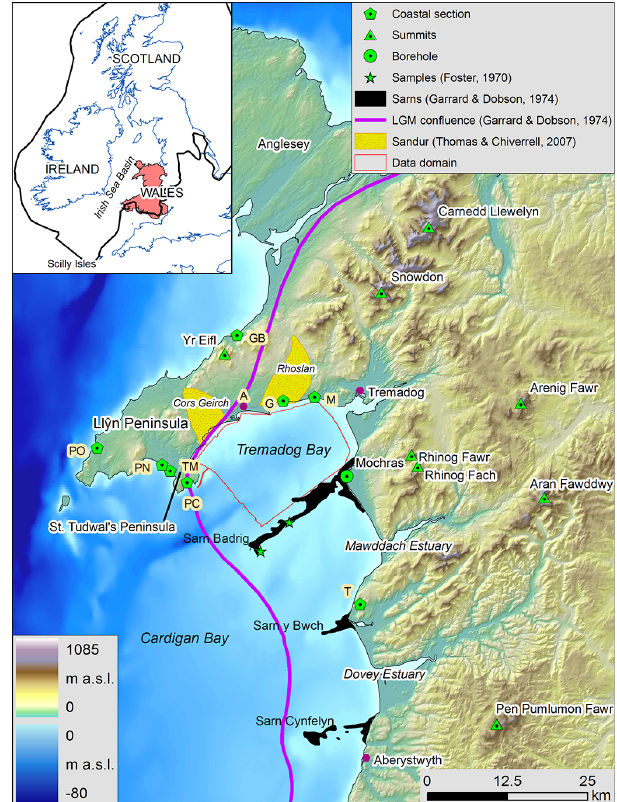
Figure 1. The terrestrially based Welsh Ice Cap, a semi- independent accumulation centre on the southern periphery of glaciation in Celtic Britain (inset box). The study area of Tremadog Bay in NW Wales, delimited in red, is bounded to the north by the Llˆyn Peninsula, and Sarn Badrig to the south. Coastal sed- imentological sections: Porth Oer (PO), Porth Neigwl (PN), Tai Morfa (TM), Porth Ceiriad (PC), Gwydir Bay (GB), Glanllynnau (G), Morannedd (M), and Tonfanau (T). Towns: Abererch (A). Re- lief is displayed using NEXTMap Britain (Intermap Technologies) data onshore, and British Geological Survey (BGS) DigBath250 bathymetry data o ff